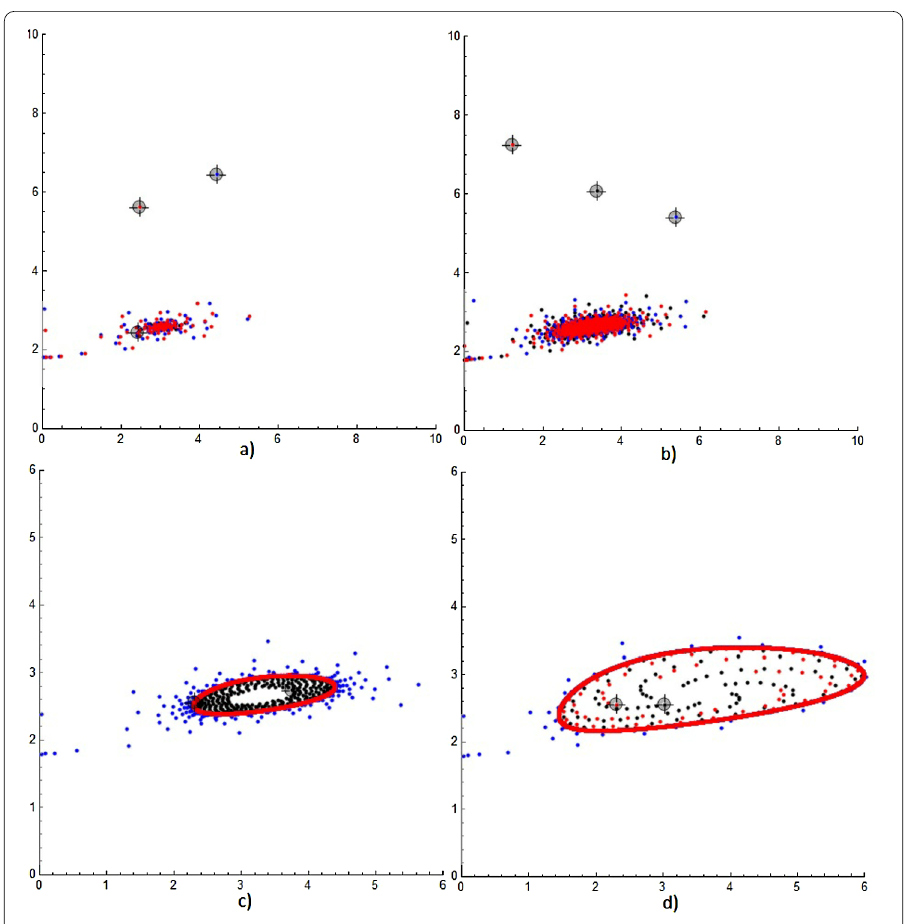
Figure 4 Trajectories (orange, black, and red) for b = 0.28, d = 1.79, m = 1.05, where a 0 ≈ 15.9885,